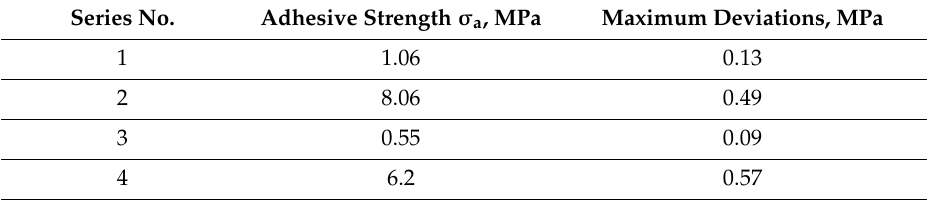
Table 4. Average values of adhesive strength and maximum deviations (series